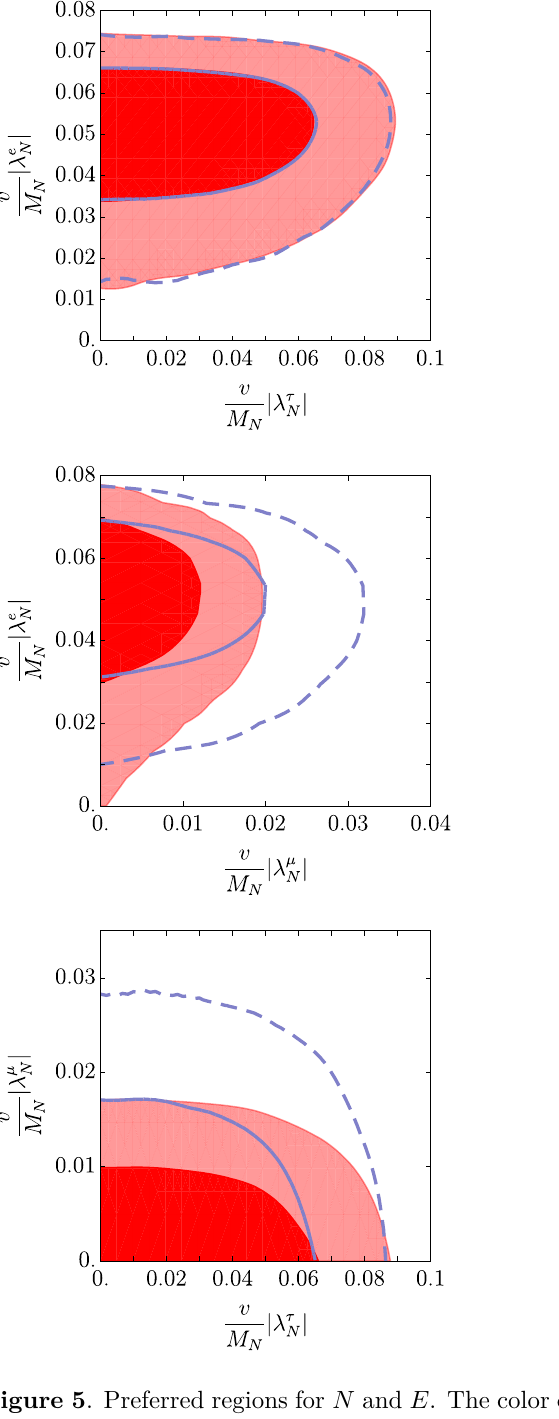
Figure 5 . Preferred regions for N and E . The color coding is the same as in figure 3 and the black line indicates the exclusion by τ → 3 µ or τ → 3 µ in case of one generation of VLLs. The exclusions from µ → e processes are very stringent and for better visibility shown in figure